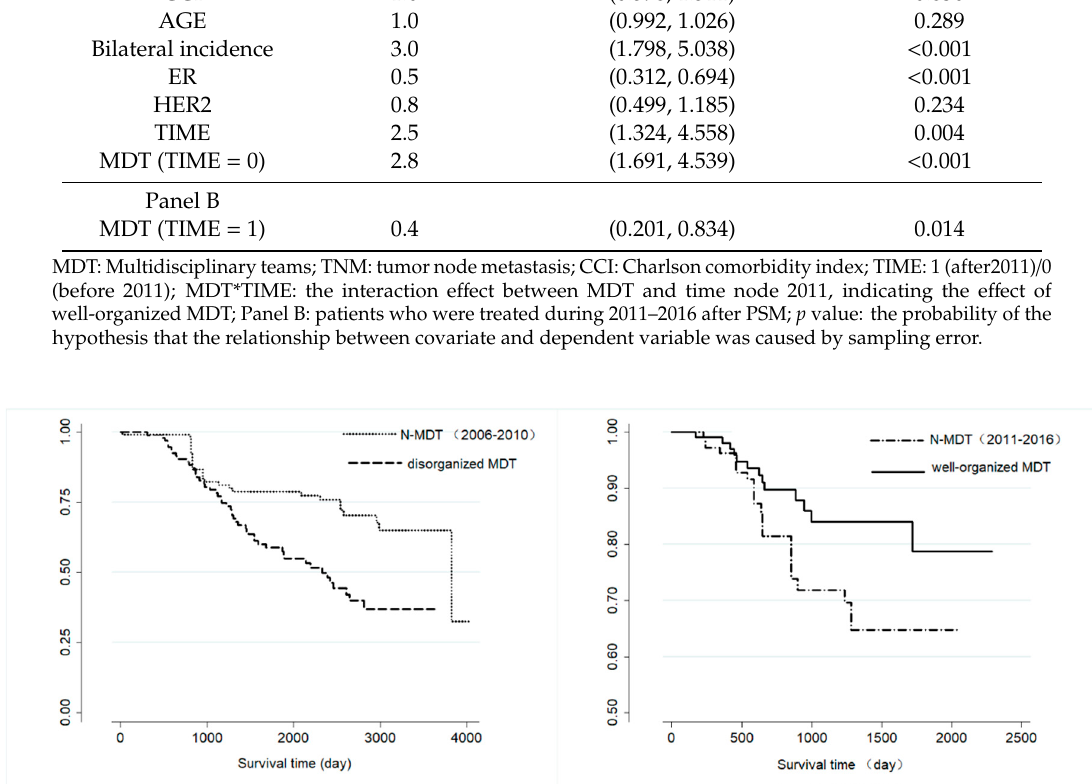
Table 5. The differential effects of MDT in Cox regressions.